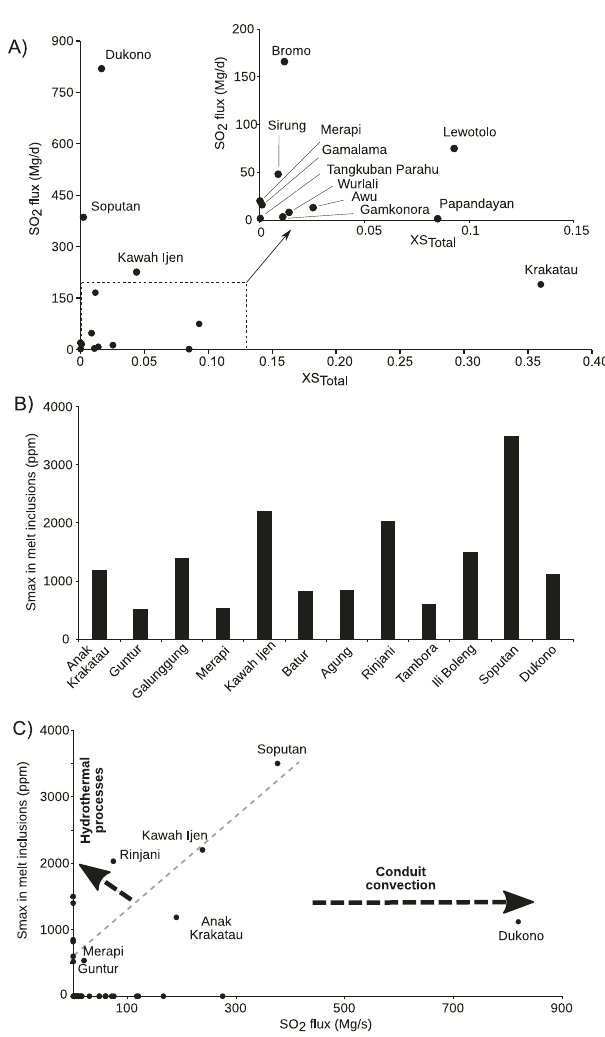
Fig. 5 Sulfur content in fl uids and melt inclusions versus SO 2 fl